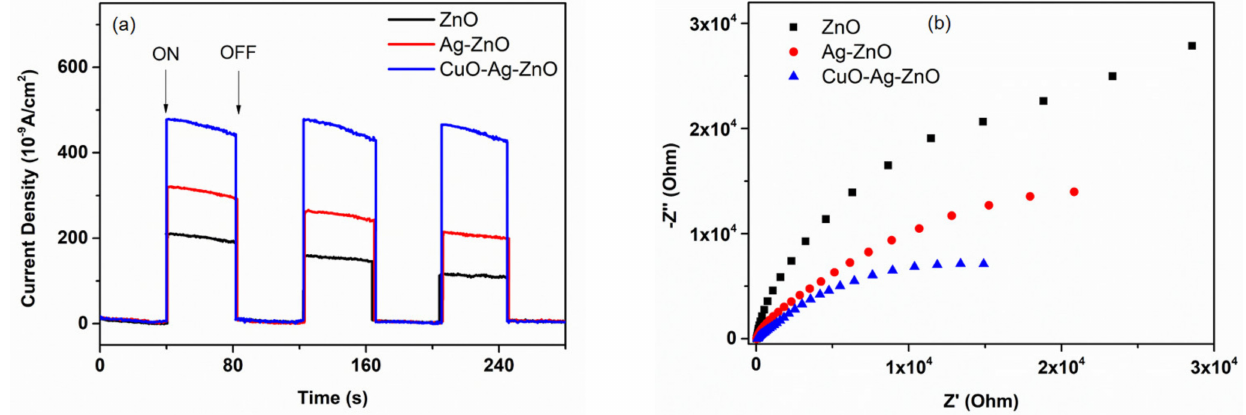
Figure 8. ( a ) The photocurrent-time curves of samples under the light on/off illumination by the solar simulated light, and ( b ) the Nyquist plot of